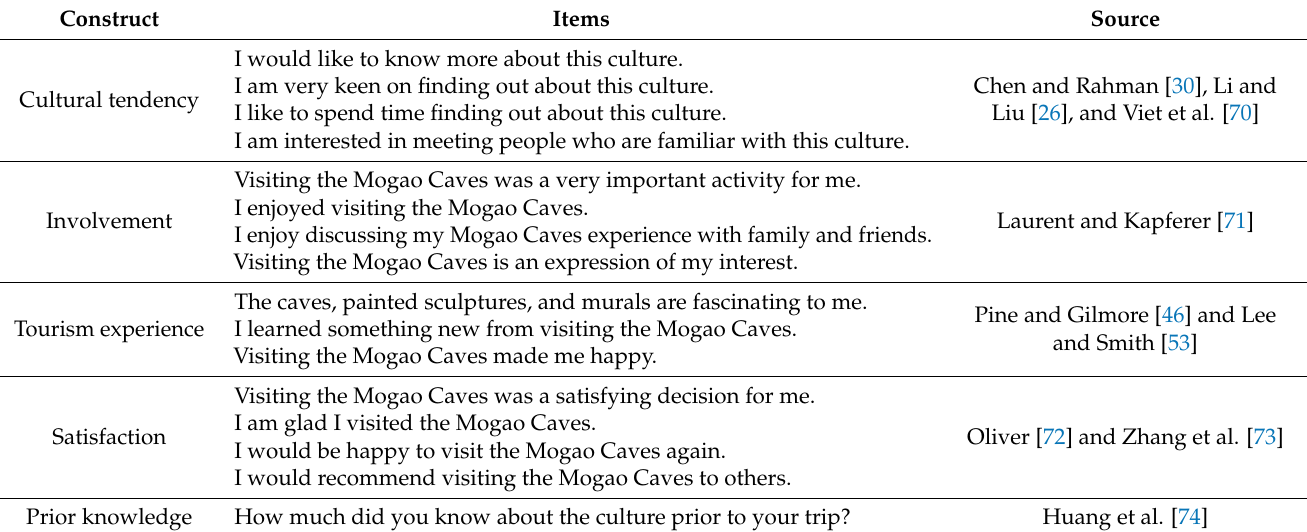
Table 3. Scale design and